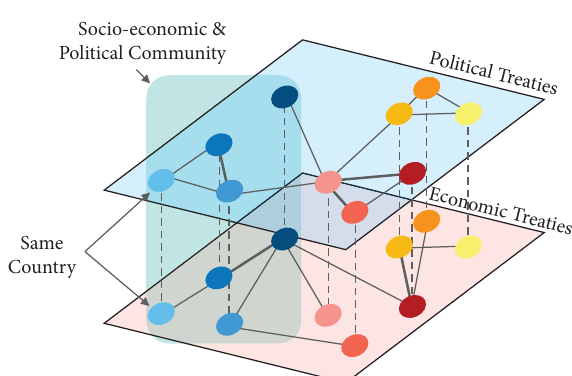
Figure 1: Multilayer network representation of socio-economic and political treaties. Nodes represent countries and edges rep- resent existing interactions between diferent relationships, such as political and economic ones, which are mapped to diferent